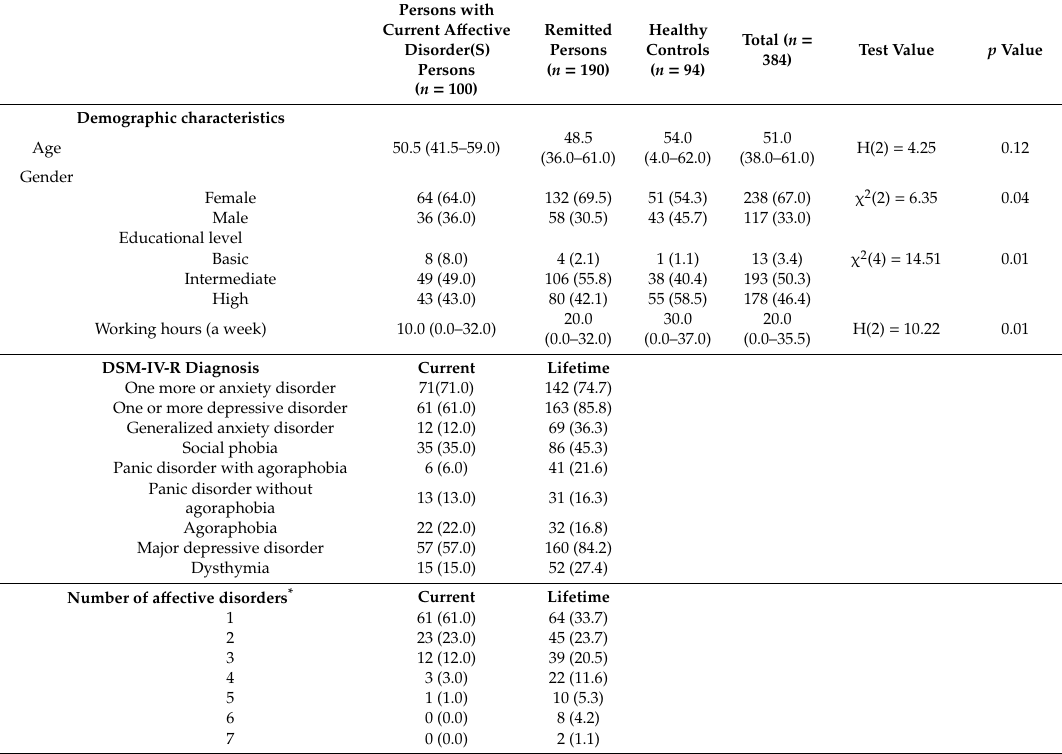
Table 1. Demographics of the study